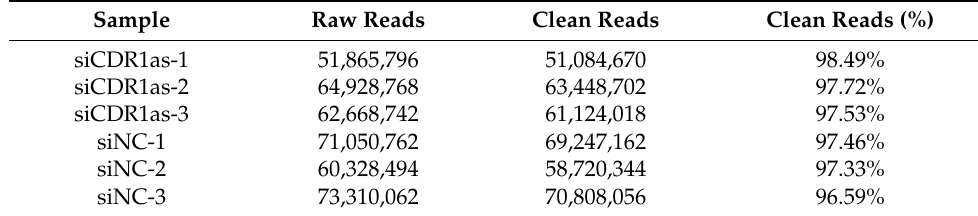
Table 2. Summary of reads from raw data and clean read for mRNAs (siCDR1as).